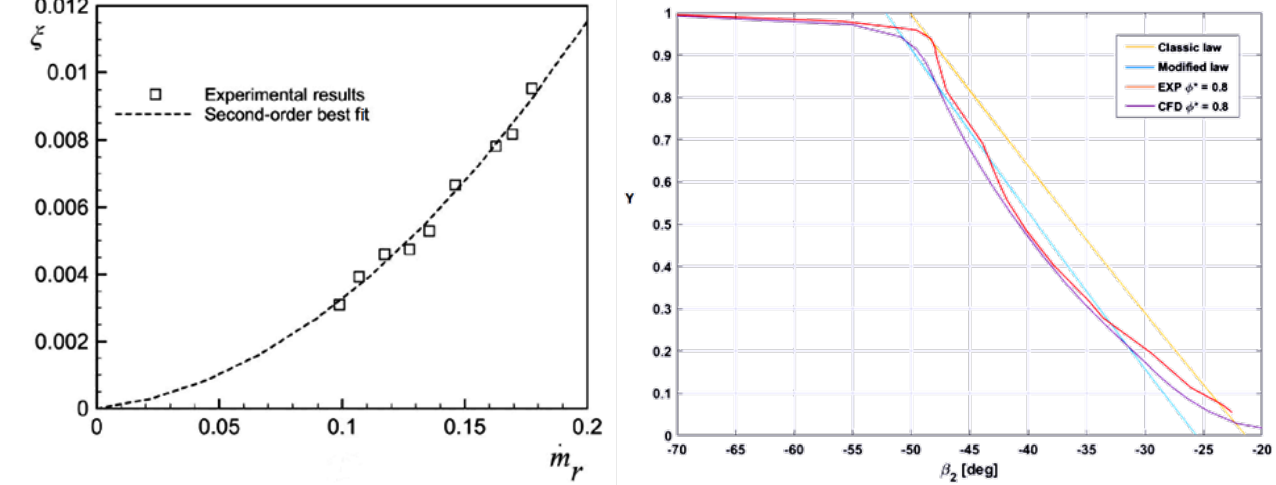
Figure 2. Loss correlation ( left ) and modified MacKenzie’s law at rotor TE ( right